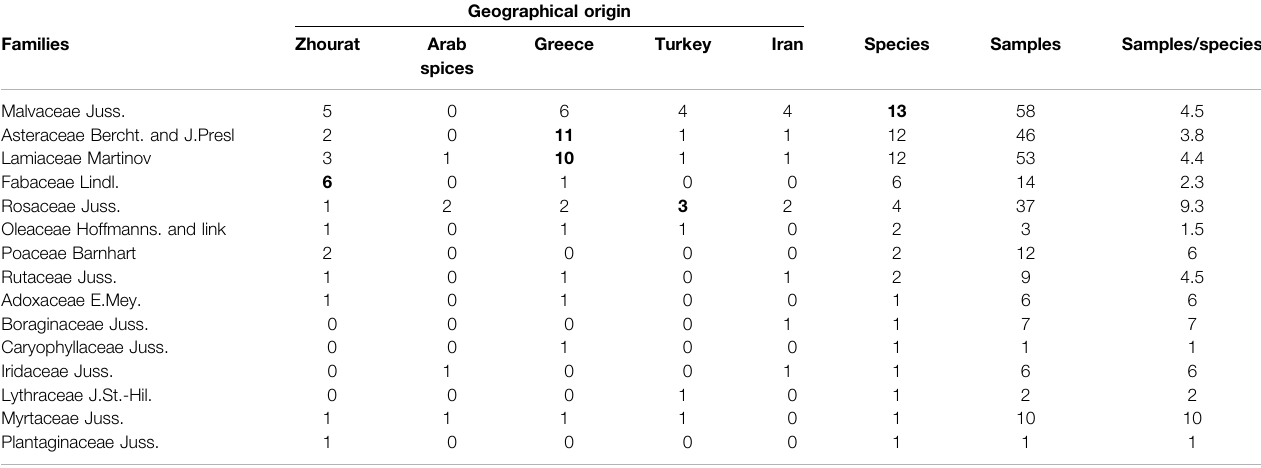
Bold character mark relevant numbers.